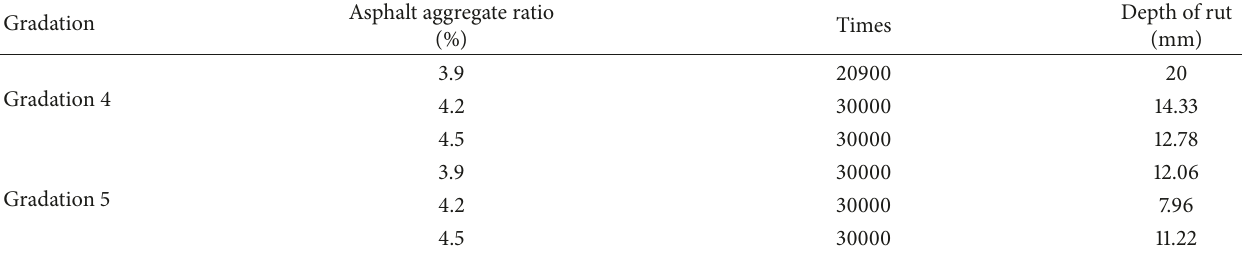
Table 10: Hamburg immersion rutting test results.